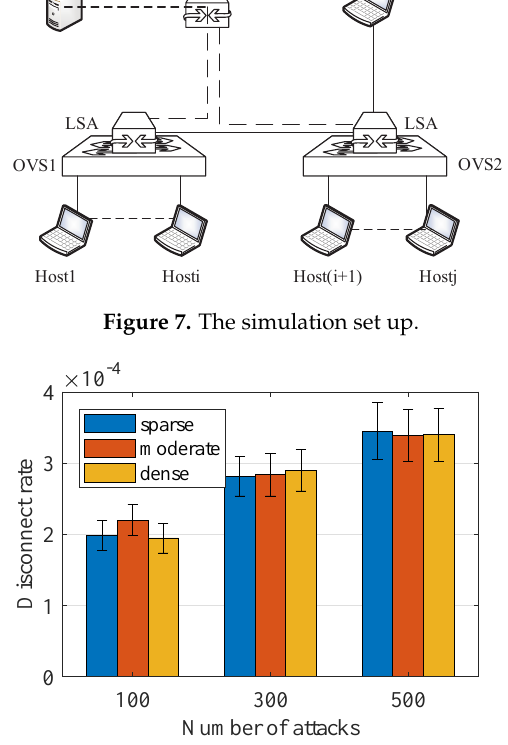
Figure 8. Performance under IP spoofing.